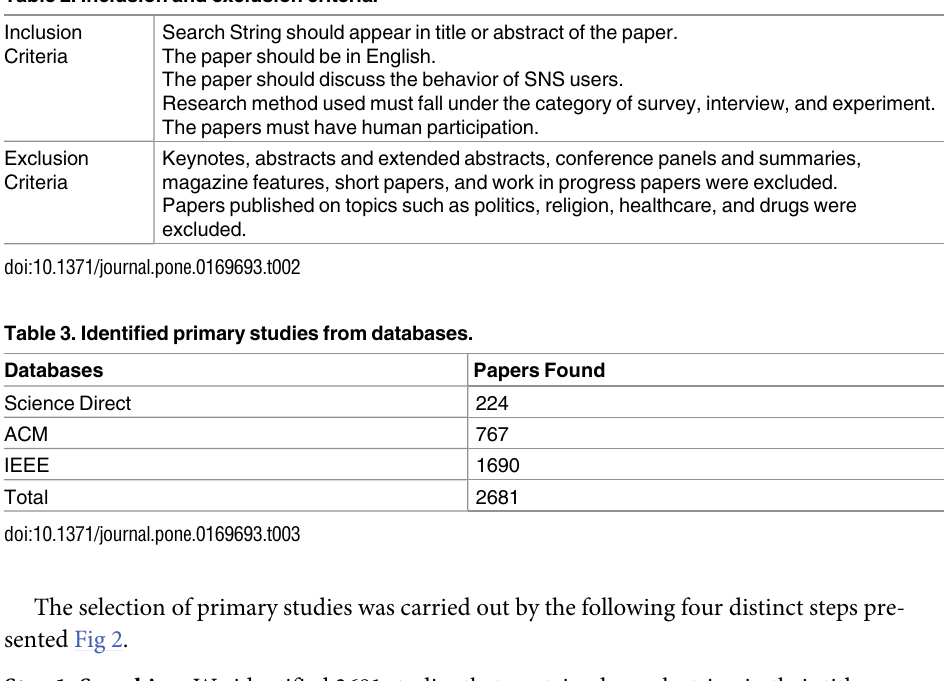
Table 2. Inclusion and exclusion criteria.